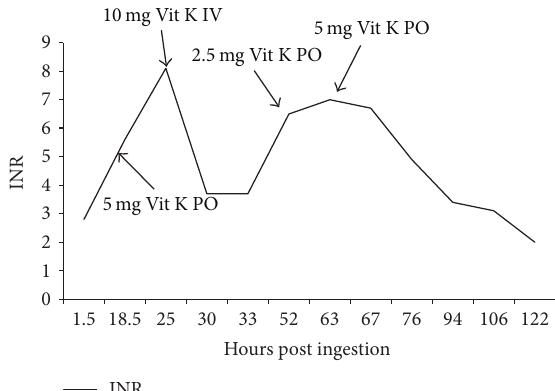
Figure 1: Patient’s INR trend during course of